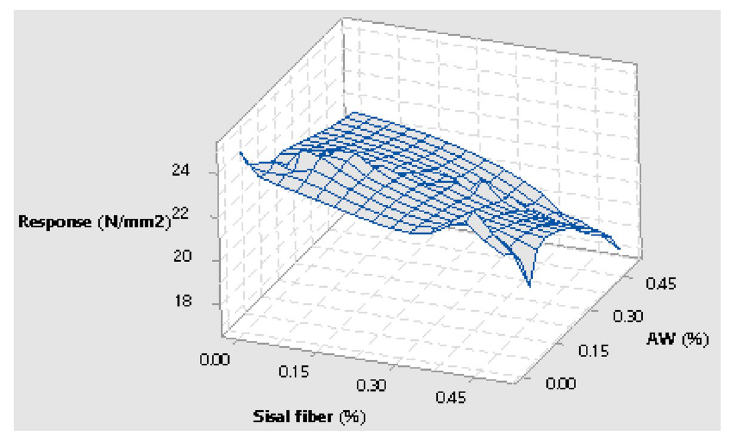
Figure 8. Concrete admixtures versus response.